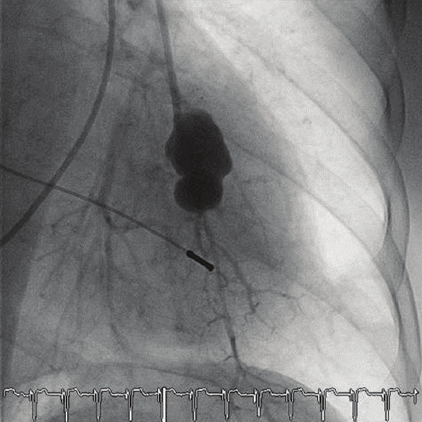
Figure 1: False aneurysm of a segment artery of the left lobe. Pul- monary angiography during hemoptysis presented extravasation of contrast media from a segment artery of the left lobe and the formation of a false aneurysm.